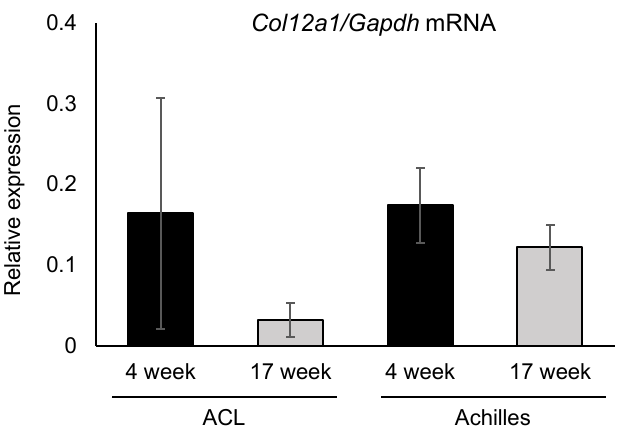
Figure 4. Expression of Col12a1 mRNA in the ACLs and Achilles tendons. The expression of Col12a1 mRNA normalized to Gapdh was measured. The Col12a1 mRNA expression level was comparable between the ACL and Achilles tendon in 4-week-old mice. The expression levels tended to decrease at 17 weeks compared with 4 weeks of age, but the differences were not statistically significant.